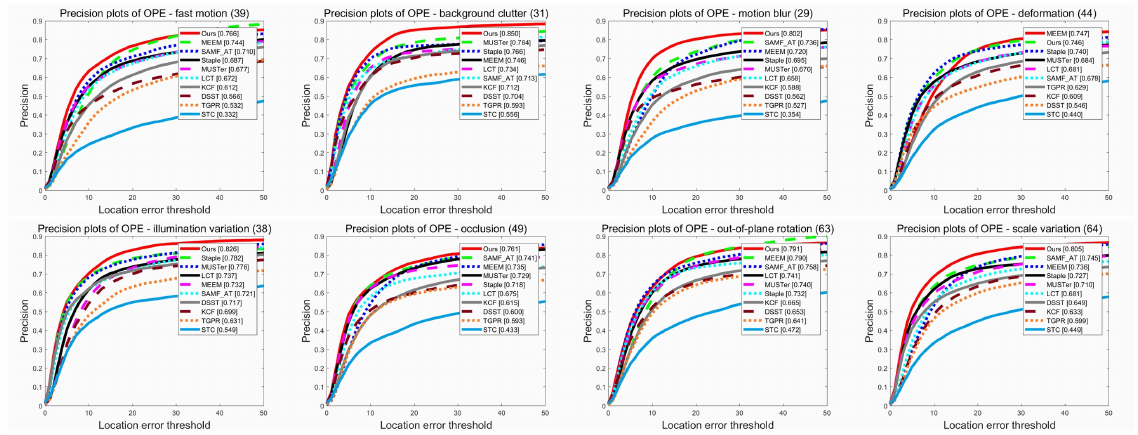
Figure 4. Performance evaluation of distance precision on eight challenging attributes (FM, BC, MB, DEF, IV, OCC, OPR and SV) of the OTB-2015 dataset.